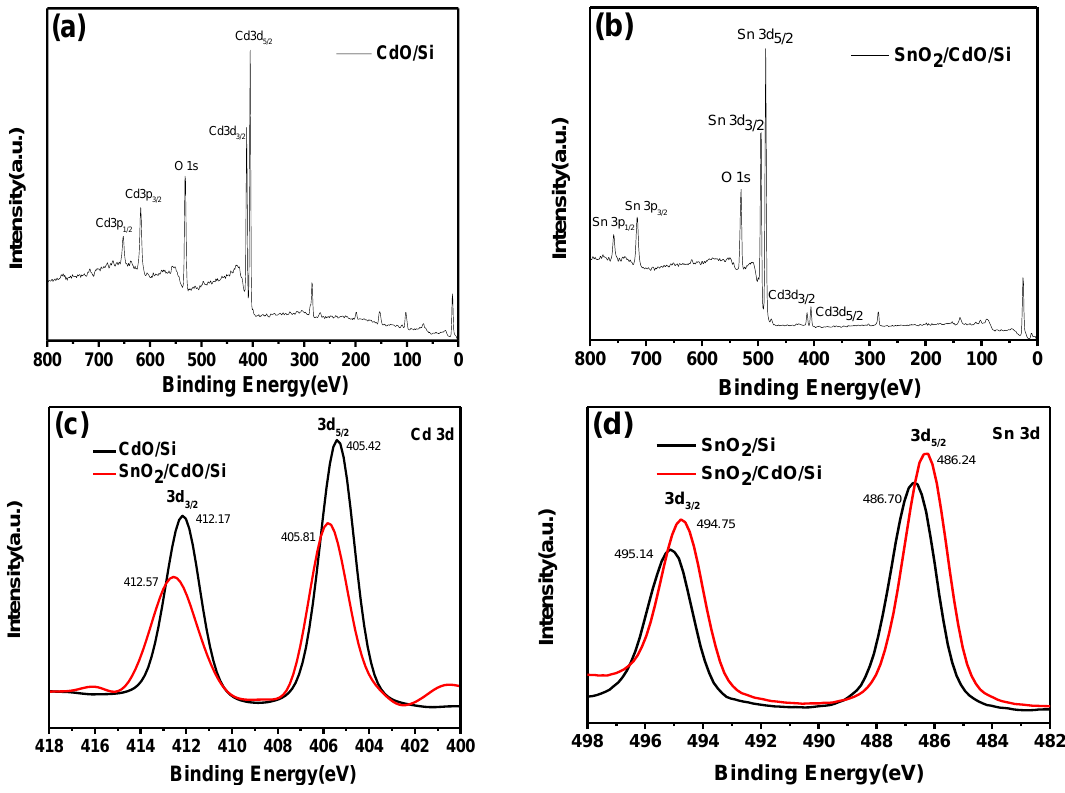
Figure 6. XPS survey spectra of ( a ) CdO/Si SLSC and ( b ) composited SnO 2 /CdO/Si DLSC. Core level ( c ) Cd 3d, ( d ) Sn 3d XPS spectra.